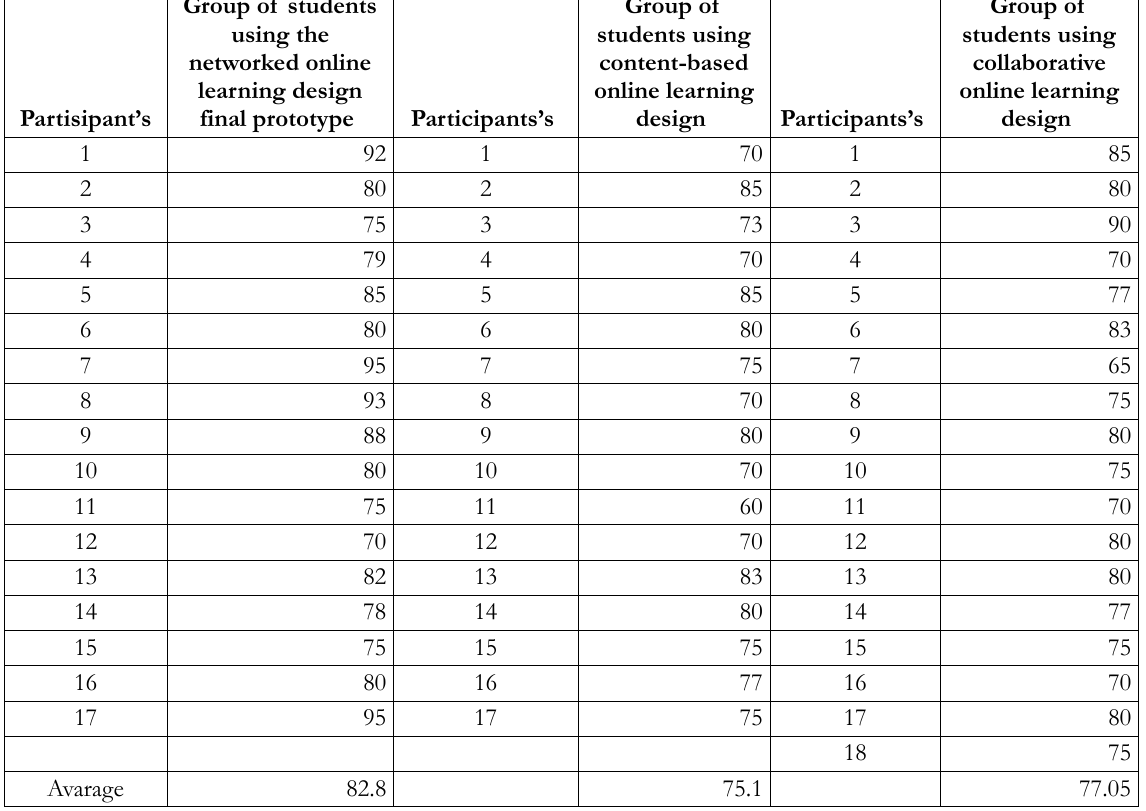
Table 7. The recapitulation of student performance